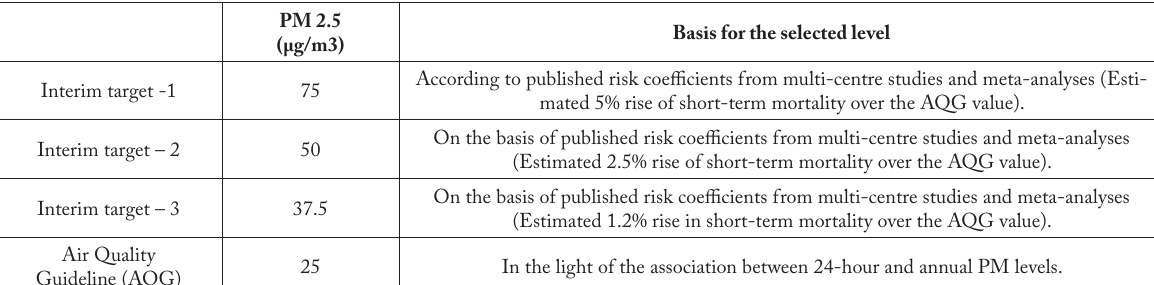
Table 2. WHO air quality guidelines and interim targets for particulate matter: annual mean concentrations (Source: World Health Organization,